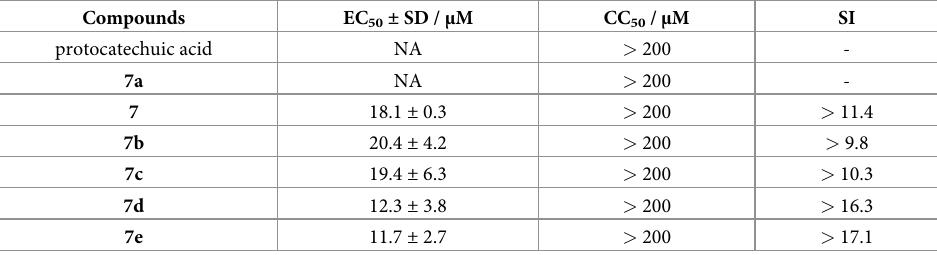
Table 3. Anti- Trypanosoma cruzi activities of protocatechuic acid and esters 7, 7a-7e.